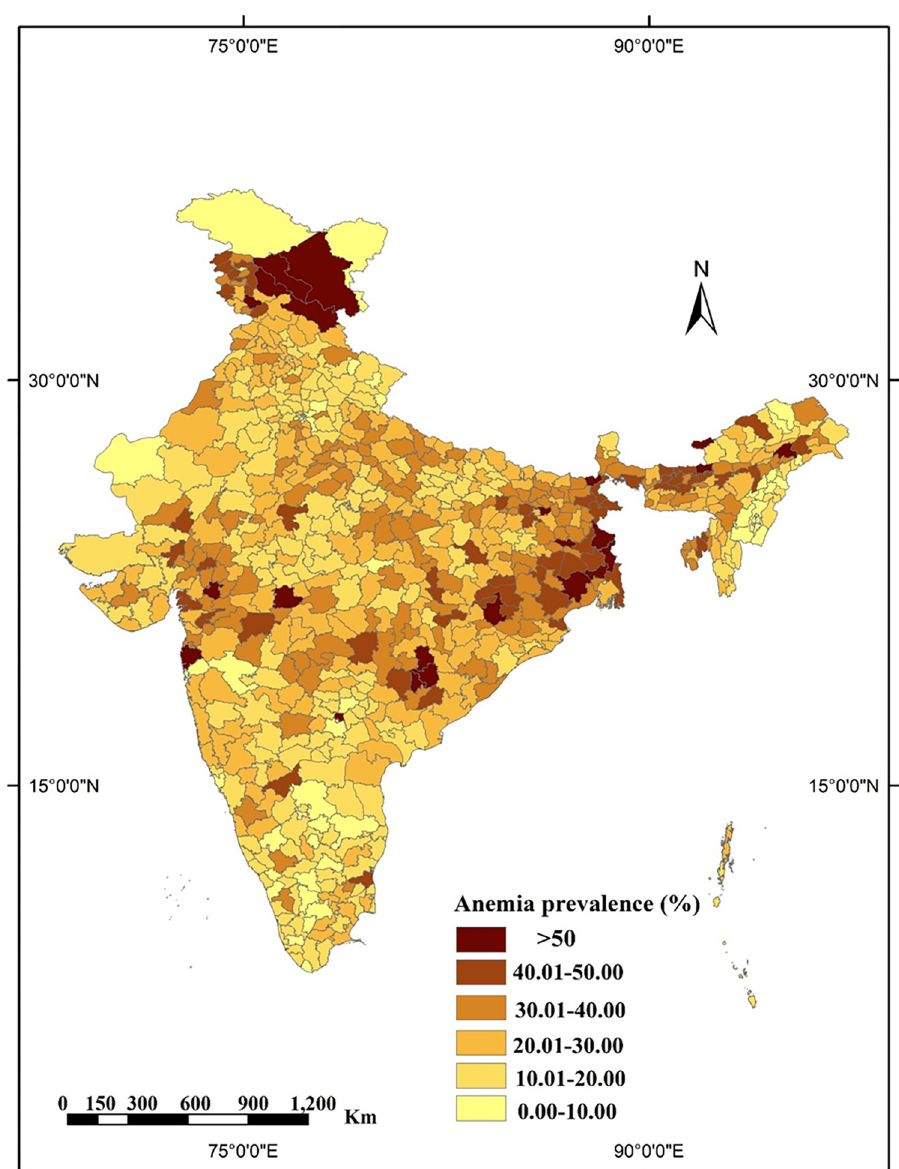
Fig 5. Map showing district wise prevalence of anaemia among rural men in India, NFHS-5, 2019–21. (All the maps used are the authors’ own creations. As far as the base layer is concerned, we used a free GIS file from https:// spatialdata.dhsprogram.com/boundaries/#view=table&countryId=IA for national and sub-national boundaries).